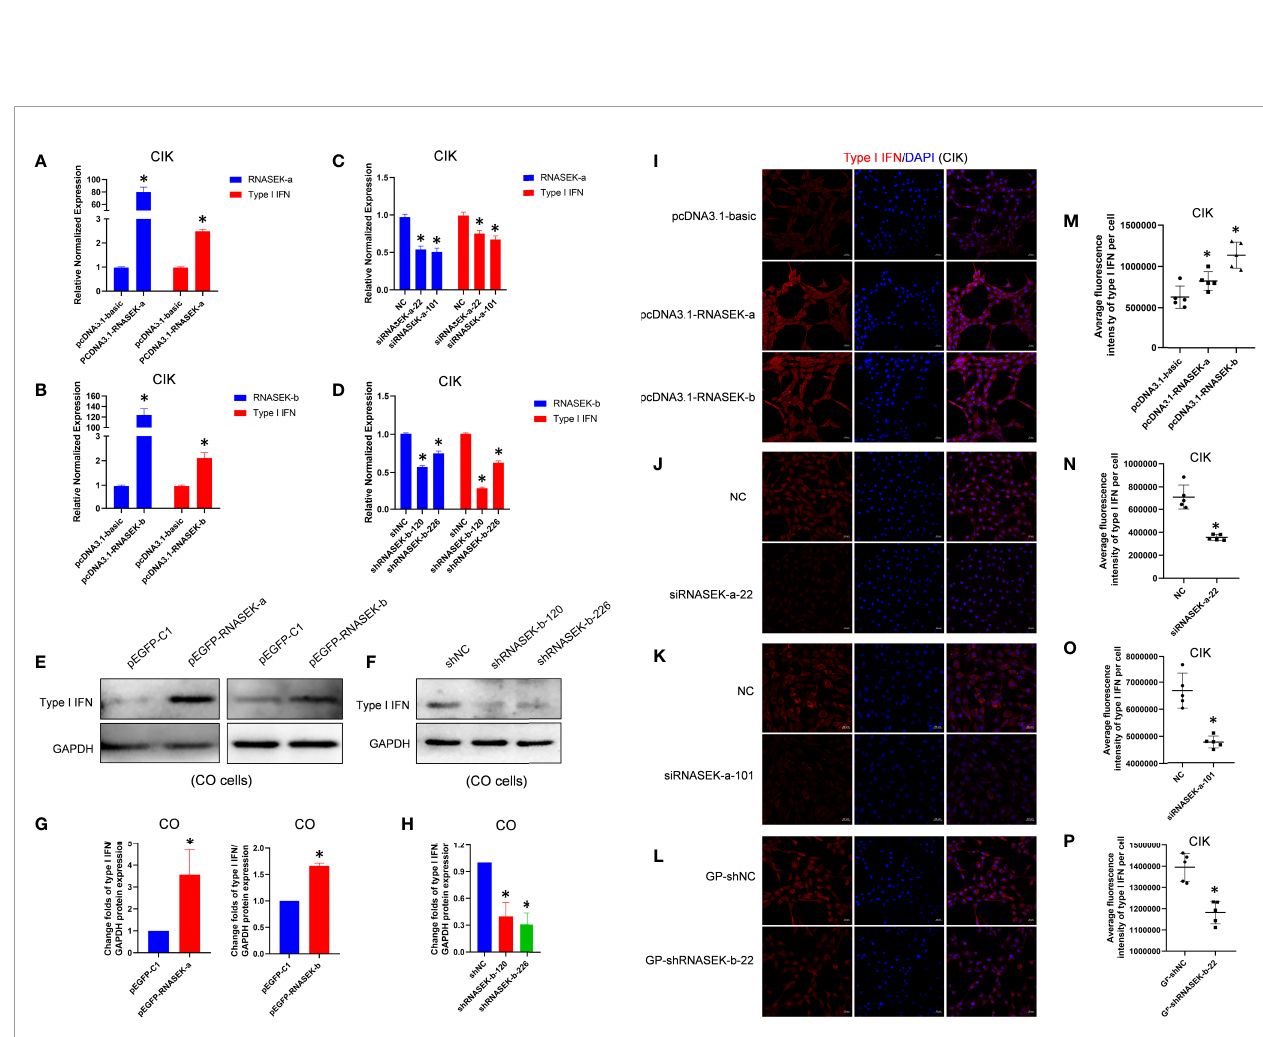
FIGURE 3 | Grass carp RNASEK-a and -b individuallypromote type I IFNexpression. (A – D) In CIK cells, type I IFN mRNA expression was assessed after overexpression of RNASEK-a (A) and-b (B) as wellas knockdown of RNASEK-a (C) and-b (D) byusing qRT-PCR intriplicate. (E,F) In CO cells, typeI IFNproteinexpression was examined after overexpression of RNASEK-a and -b (E) as well as knockdown of RNASEK-b (F) through Western blot with GAPDH as a loadingcontrol. (G,H) The grayscalevalues of type I IFN bandsrepresenting (E) and (F) were individually calculated bythe ImageJ software ( n = 3 – 5; the control data were normalized to 1). (I – L) In CIK cells, typeI IFN protein expression was observed via immuno fl uorescent staining after RNASEK-a and-boverexpression (I) , siRNASEK-a-22 (J) and -101 (K) -mediatedknockdownof RNASEK-a, and GP-shRNASEK-b-22 (L) -mediated knockdown of RNASEK-b.Images were taken under 200× magni fi cation by using the Zeiss confocal microscope(red, type I IFN; blue, DAPI; scalebar,20 m m). (M – P) Five random views representing (I – L) were selected to determine the statisticalsigni fi cance, respectively. Overexpression of RNASEK-a and-bwas performed via transfection of relative recombinant plasmids, includingpcDNA3.1-RNASEK-a, pcDNA3.1-RNASEK-b,pEGFP-RNASEK-a, and pEGFP-RNASEK-b.The knockdownofRNASEK-a was conducted by siRNA against RNASEK-a-22 and -101. RNASEK-b knockdownwas carried out with GP- shRNASEK-b-22, shRNASEK-b-120, and-226. Cell type is marked in each image. The relative normalized mRNA expression ofgenes was obtained byusing the 2 − DD CT method with b -actin as an internal control (A – D) . The controls consist ofpcDNA3.1-basic (A,B, I, M) , NC (C, J, K,N,O) , shNC (D,F, H) , GP-shNC (L, P) , and pEGFP-C1 (E,G) . Allvalues are mean ± SD. The results are representativeof three independent experiments. * P < 0.05 versusthe